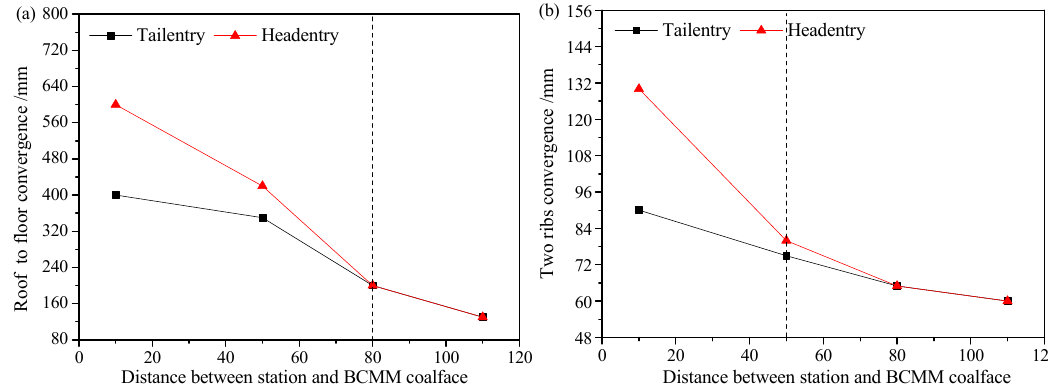
Figure 11. The deformation curves of the entries in front of the BCMM coalface: ( a ) roof-to-floor convergence; ( b ) two-rib convergence.